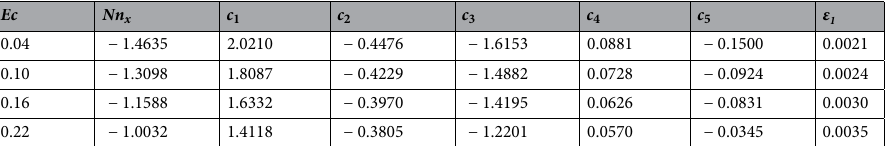
Table 7. Quadratic regression approximated coefficients of Nn x owing to variations in D and Tr and also optimum relative error bound ε 1 are obtained as